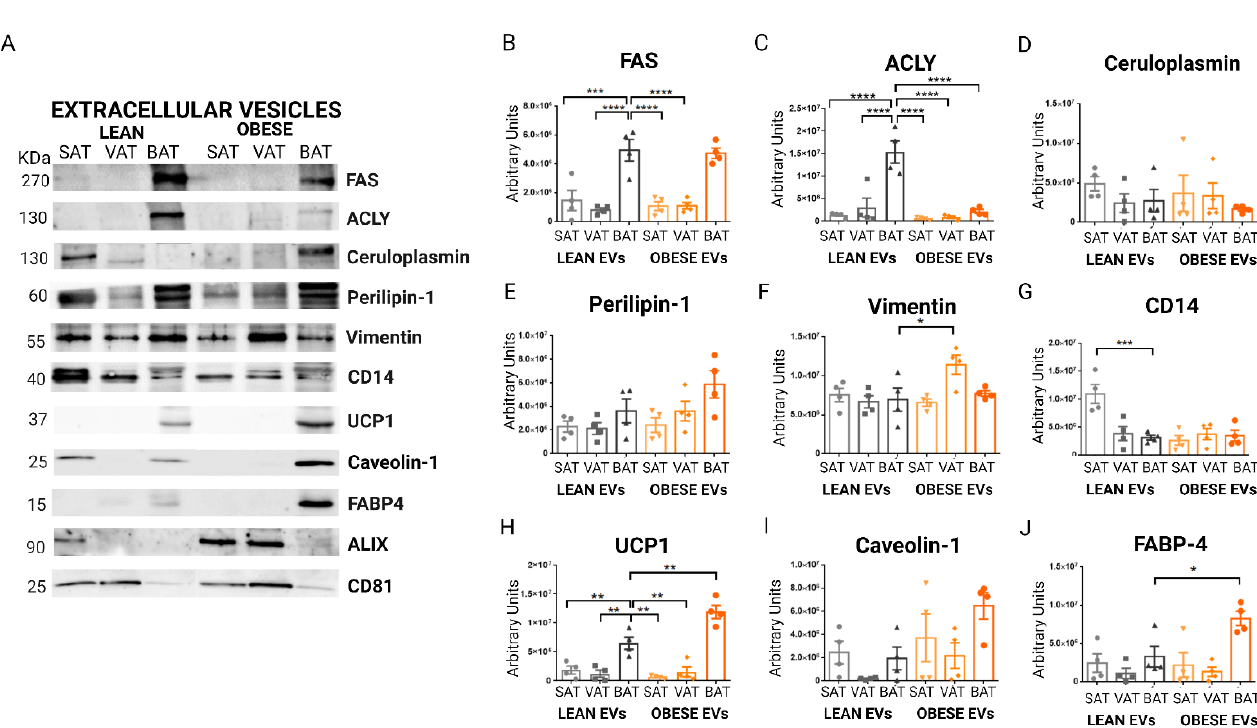
Figure 7. Immunodetection validation of vesicular proteins identified as potential biomarker candidates for brown adipose tissue (BAT) and white fat in the DIA-SWATH/MS analysis (sequential window acquisition of all theoretical fragment ions) in EVs secreted from 1 g of AT from obese and lean animals. Representative images are shown of: ( A ) immunodetection; ( B ) graphs of band quantification for FAS protein (fatty acid synthase); ( C ) ACLY (ATP-citrate synthase); ( D ) ceruloplasmin; ( E ) perilipin-1; ( F ), vimentin; ( G ) CD14; ( H ) UCP1 (mitochondrial uncoupling protein of brown fat 1); ( I ) caveolin-1; ( J ) FABP4 (fatty acid binding protein 4 of adipocytes) ( n = 4 independent lysates for each sample type). Differences were analyzed using a one-way ANOVA and Kruskal–Wallis test, followed by Dunn’s multiple comparison test ( p ≤ 0.05 was considered to be statistically significant; * p < 0.05, ** p < 0.01, *** p < 0.001, and **** p < 0.0001). Raw densitometry data, and complete immunoblot images are shown in Supplementary Materials File S3. EVs, extracellular vesicles;